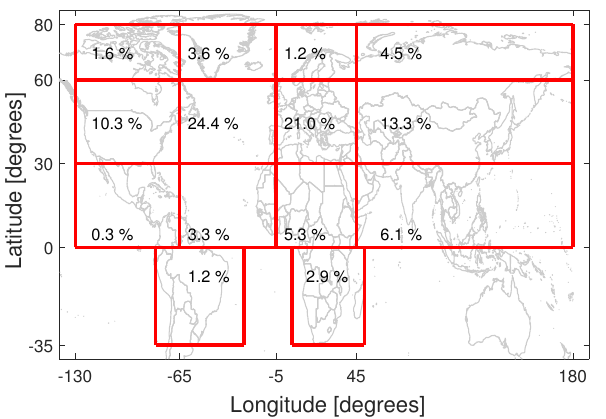
Figure 3. Relative frequency of the IAGOS temperature observa- tions at cruise altitude ( p < 350hPa) in different regions (Table 1). The total number of 1min averages is 14.8 million. Note, 1% in- cludes 0.2 million 1min mean data points within the UTLS region.